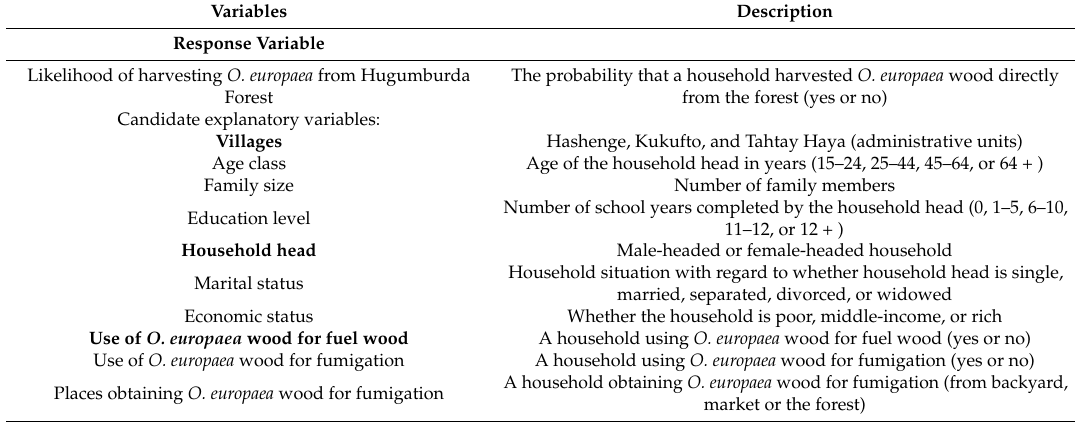
Table 1. Description of response and candidate explanatory variables used in the model within the socioeconomic dataset. Only explanatory variables in bold were included in the full model explaining the Likelihood of harvesting Olea europaea (Wall. ex G. Don) Cif. from Hugumburda Forest. The other variables were not included in the full model, either because they had no significant influence on the response variable or because they were strongly correlated ( r > 0.7) with one or more of the variables in